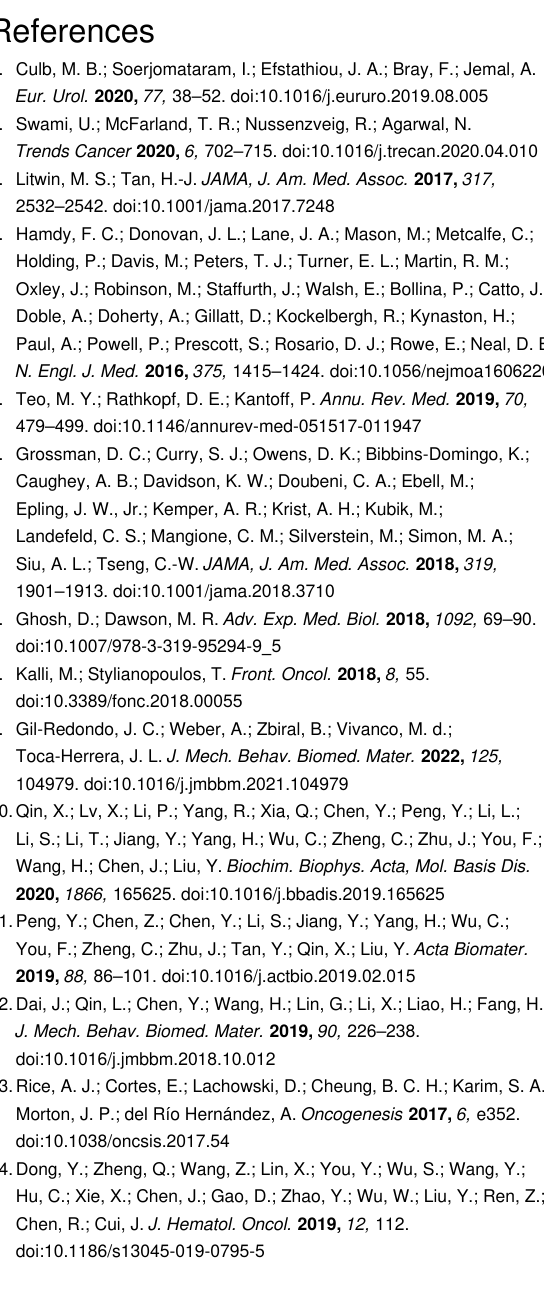
Figure S1: The toxic effect of polyacrylamide hydrogel substrates on prostate cancer cells. Figure S2: The effect of substrate stiffness on cell proliferation. Figure S3: The effect of substrate stiffness on cell morphology. Figure S4: The effect of blebbistatin on PCa cytoskeleton microfilaments. Figure S5: The effect of blebbistatin on PCa cell migration. Figure S6: Mechanical properties respond to the effect of substrate